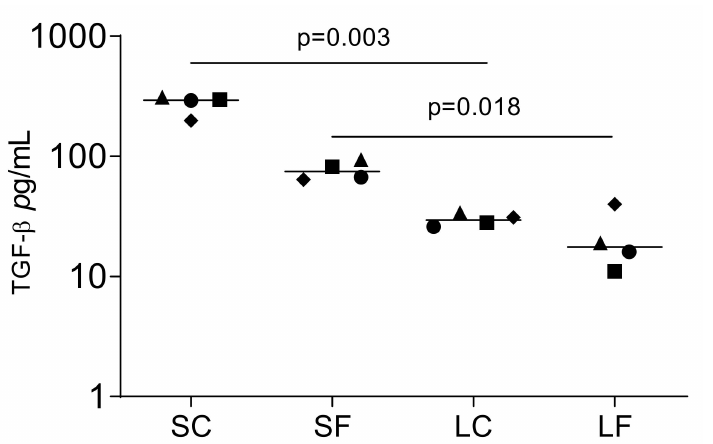
Figure 1. Supernatants that are the aqueous solution of OraGRAFT ® Demineralized Cortical Particu- late (SC) and OraGRAFT ® Prime (SF) contain TGF- β 1. The immunoassay identified less TGF- β 1 in the acid lysates of OraGRAFT ® (LC and LF). N = 4. Statistic is based on a paired t